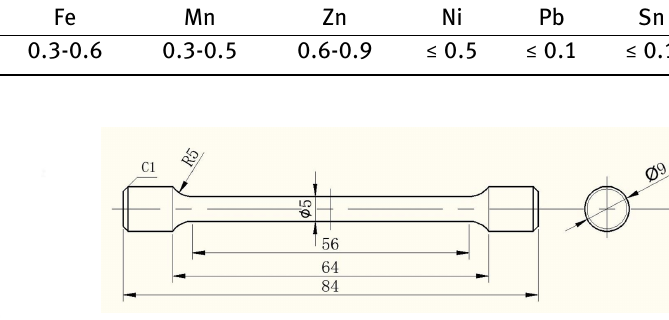
Figure 2: Tensile specimen